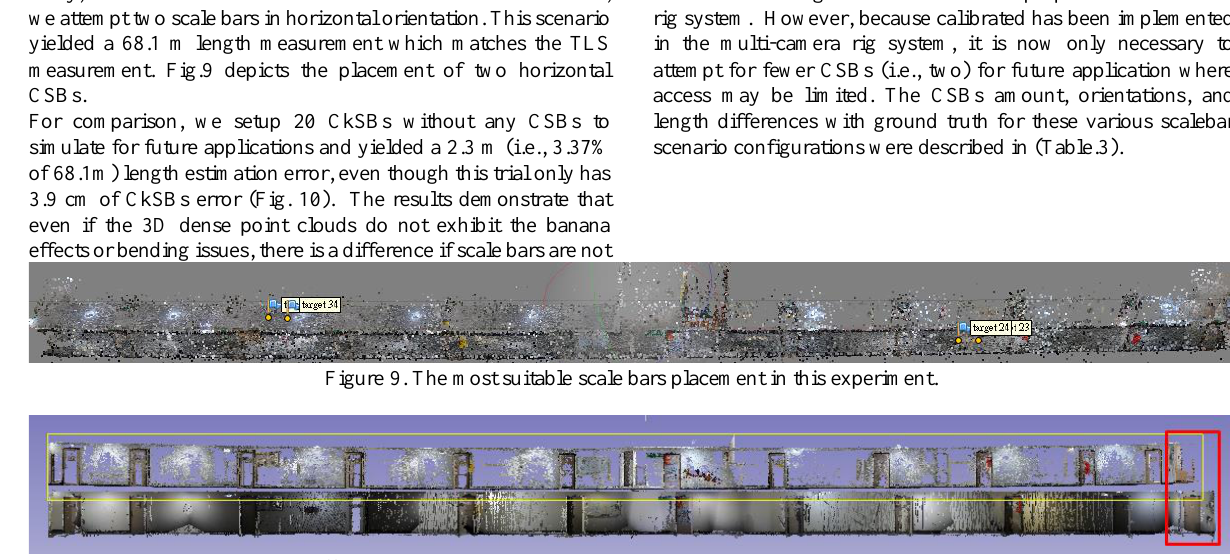
Figure 10. The difference between TLS and the calibrated unstitched images without control scale bars, it has obtained 3.38% of length error over a 68.1 m long corridor area. Table 3. Control scale bars amount and